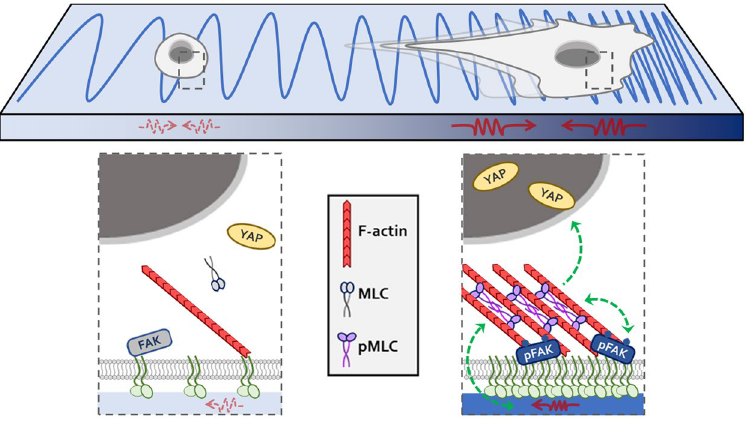
Figure 12. Summary of the reported mechanosensing behavior of ovarian cancer cells. The top panel depicts cells ( grey ) adhered to a model microenvironment with a gradient of rigidity, increasing from left to right (depicted by the depth of blue shading and density of the blue ‘spring’ coils). Individual SKOV3 and highly metastatic SKOV3.ip1 cells adhere to FN-coated hydrogels of low rigidity but fail to spread or form focal adhesions or organized actin filaments. This is accompanied by low levels of phosphorylated myosin light chain (pMLC), low traction forces ( upper panel, red ‘ springs ’), low cell motility, and nuclear exclusion of YAP1. Cells adhered to stiffer substrates show significantly increased focal adhesion formation, F-actin organization, and MLC phosphorylation, which reinforce each other and support increased cell spreading, cellular traction forces, and nuclear accumulation of YAP1. Also, globally-increased substrate stiffness supports higher levels of cell migration while directional increases in matrix tension promote directional durotaxis. These differences at the individual cell level are reflected at the level of multicellular spheroids, where disaggregation is enhanced by matrix stiffness through a mechanotransduction pathway involving ROCK, actomyosin contractility, and FAK. Some design elements of this schematic were inspired by Plotnikov & Waterman 52